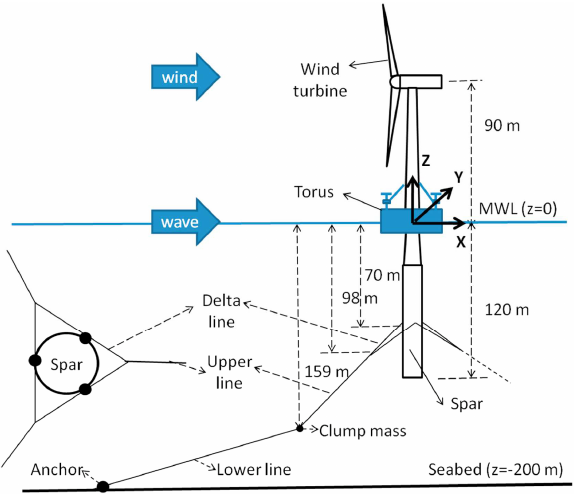
Figure 5. Spar torus combination conceptual sketch. Adapted with permission from Ref. [64]. 2015,